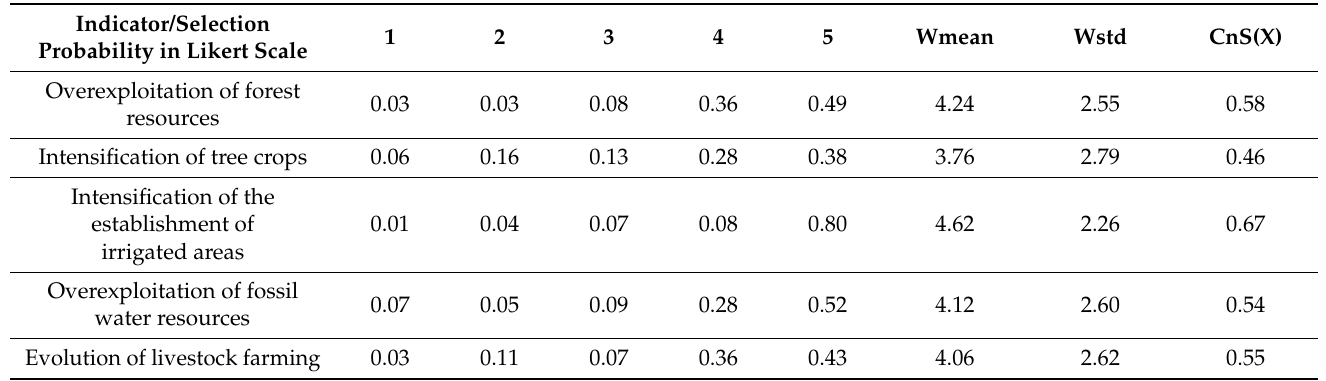
Table 7. Pressures perceived by household due to land use/land cover changes.